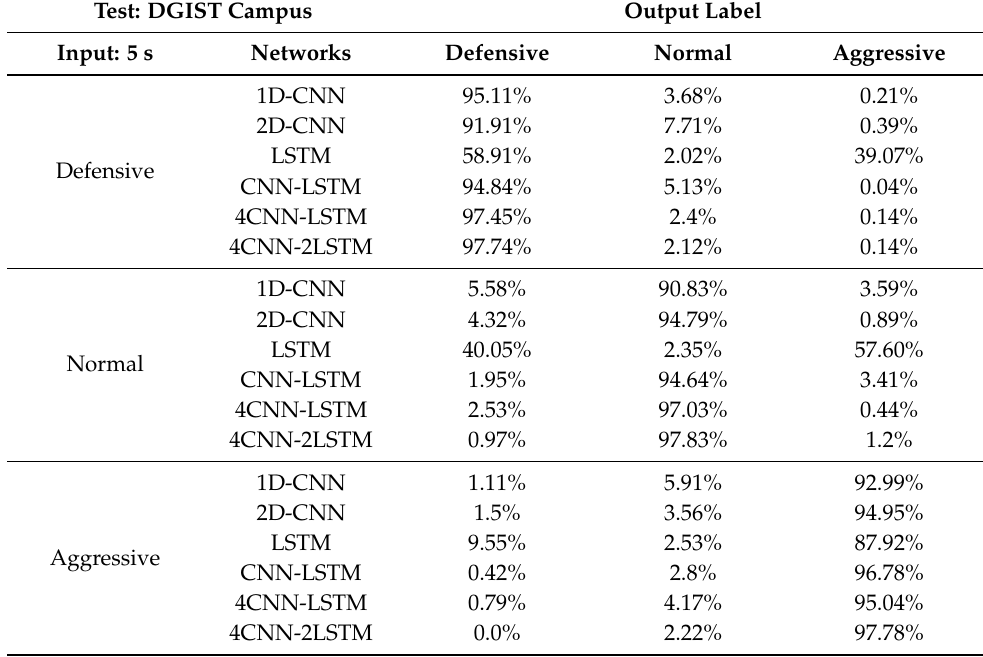
Table 6. Confusion matrix of DGIST campus driving behavior classification